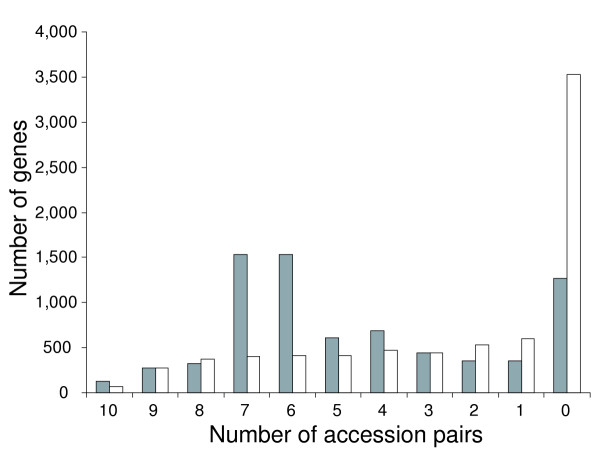
Correlation analysis of expression patterns of genes among the five accessions. A histogram based on the number of genes in each of the 11 groups in Table 3 that have Pearson correlation coefficients less than 0.5 in a given number of pairwise comparisons (see Table 3 for explanation). The white bars indicate the numbers of genes from the experimental datasets, and the gray bars indicate the average numbers of genes from the 10 permuted datasets, as described in Materials and methods.